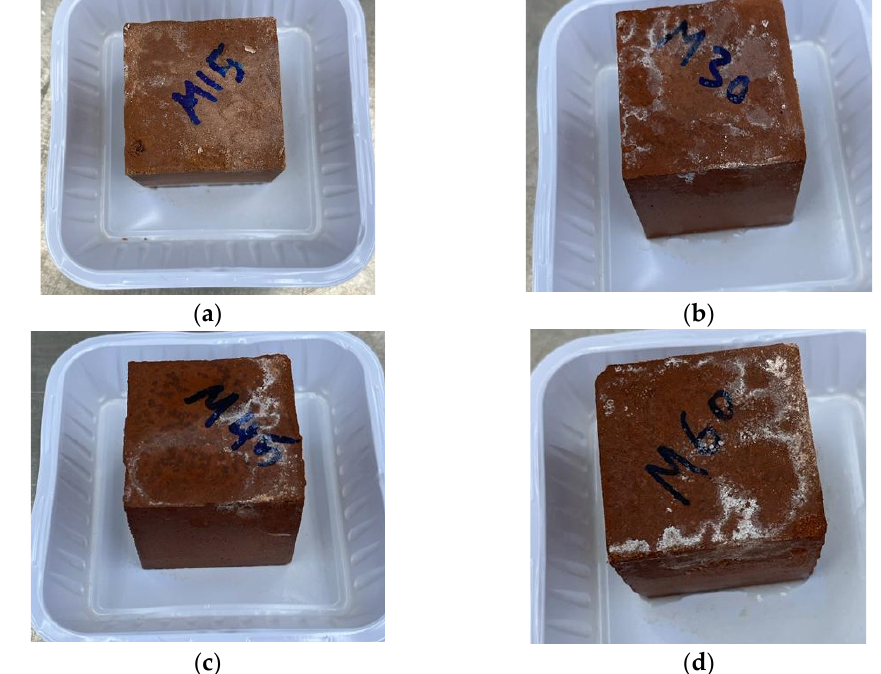
Figure 13. Efflorescence of hardened alkali-activated GBFS sample with both (DCP + RM) in contact with water. ( a ) 7.5% DCP + 7.5% RM; ( b ) 15% DCP + 15% RM; ( c ) 22.5% DCP + 22.5% RM; and ( d ) 30% DCP + 30% RM.